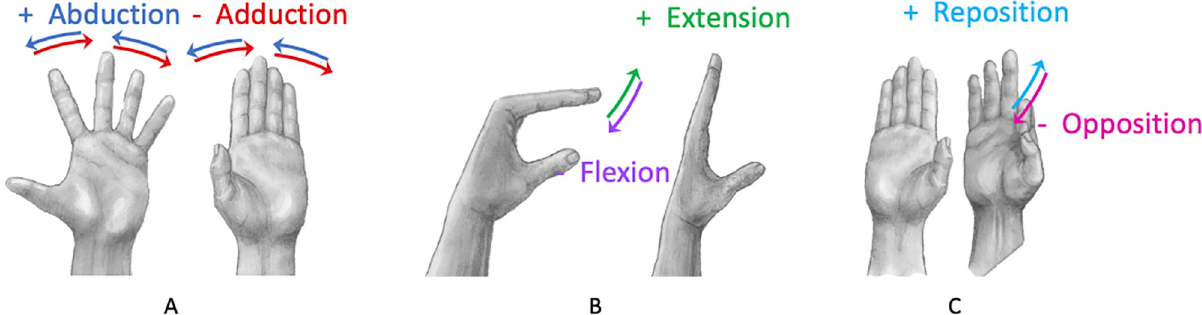
Fig 2. Video recordings captured from frontal view. Twelve healthy participants at the Upper Limb Motion Analysis Laboratory at Imperial College London.